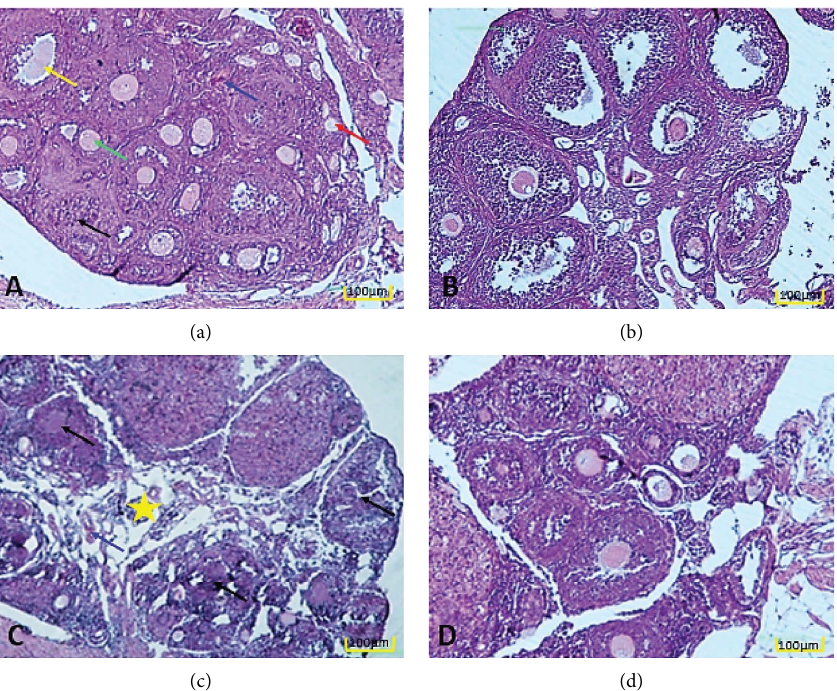
Figure 3: Light micrographs of ovarian tissue (H&E staining). (a) Control, (b) sham, (c) FA, and (d) FA +CUR. Normal histological structure (a, b). Along with a rise in edema in the medulla and vascular hyperemia, more atretic follicles were seen (c). Tere is less interstitial edema and follicular damage (d). Yellow arrow: graafan follicle, green arrow: secondary follicle, black arrow: atretic follicle, red arrow: primary follicle, and blue arrow: blood vessel; ∗ ovarian medulla with edema. Magnifcation: 10X/scale bar: 100 µ m. H&E: hematoxylin and eosin, FA: formaldehyde, and CUR: